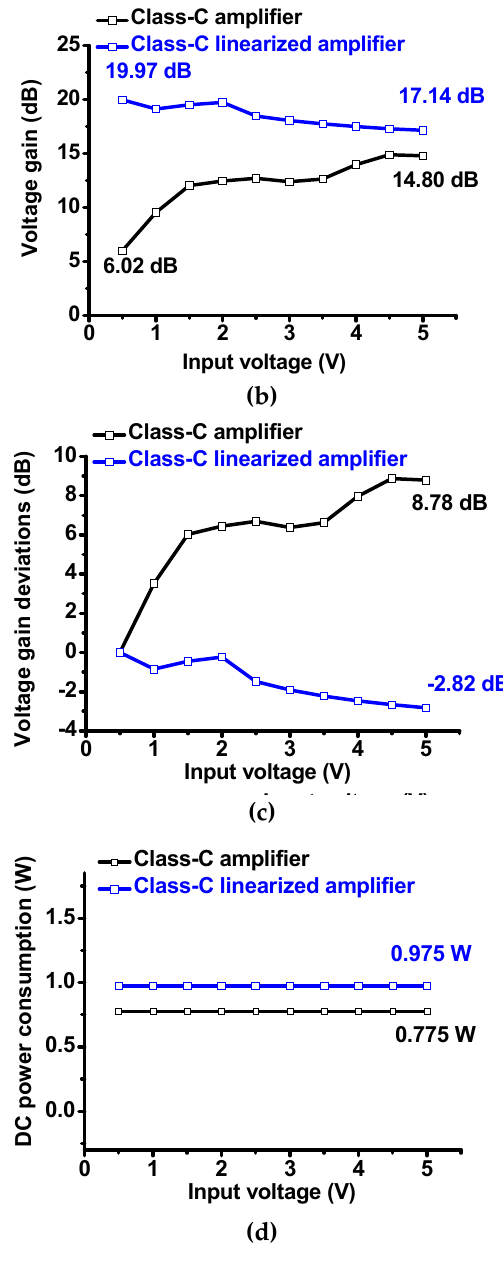
Figure 5. ( a ) Schematic diagram and photo of measurement setup; ( b ) voltage gain versus input peak-to-peak voltage amplitudes of class-C amplifier and class-C linearized amplifier; ( c ) voltage gain deviations vs. input peak-to-peak voltage amplitudes of class-C amplifier and class-C linearized amplifier; ( d ) DC power consumption versus input peak-to-peak voltage amplitudes of class-C amplifier and class-C linearized amplifier.